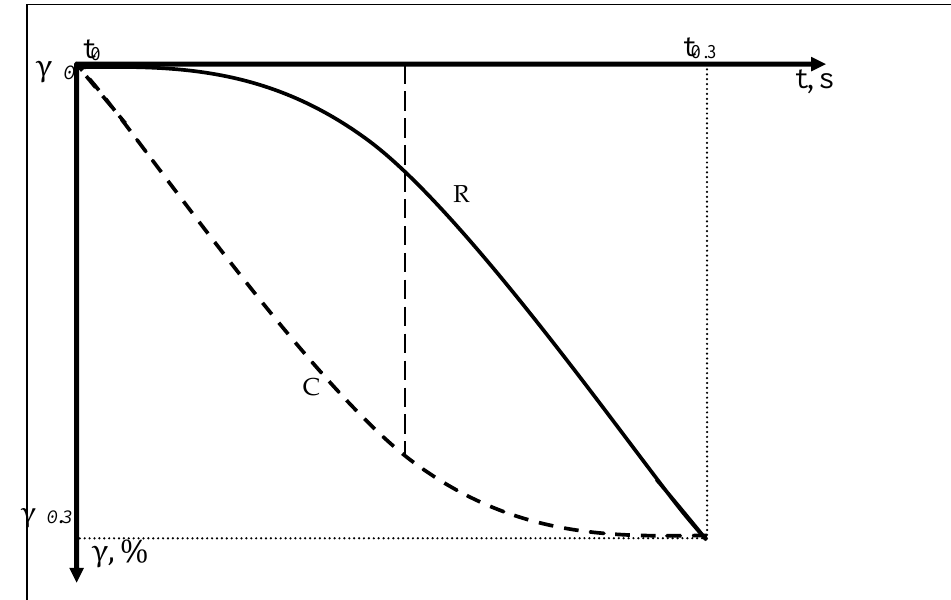
Figure 2. Change in the thickness of the composite sample under short-term cyclic compression loads. C is compression from 0 s (t 0 ) to 0.3 s (t 0,3 ) , R is recovery from 0.3 s (t 0,3 ) to 0.6 s (t 0 ) .